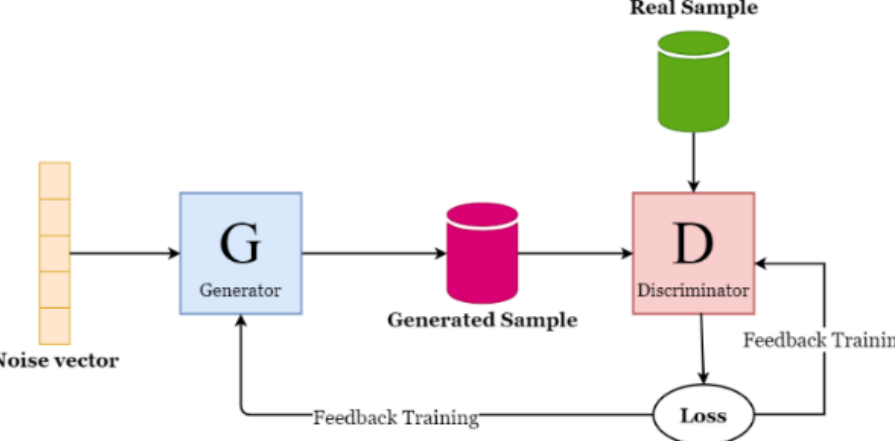
Figure 1. Generative adversarial network ’ s functional block diagram.